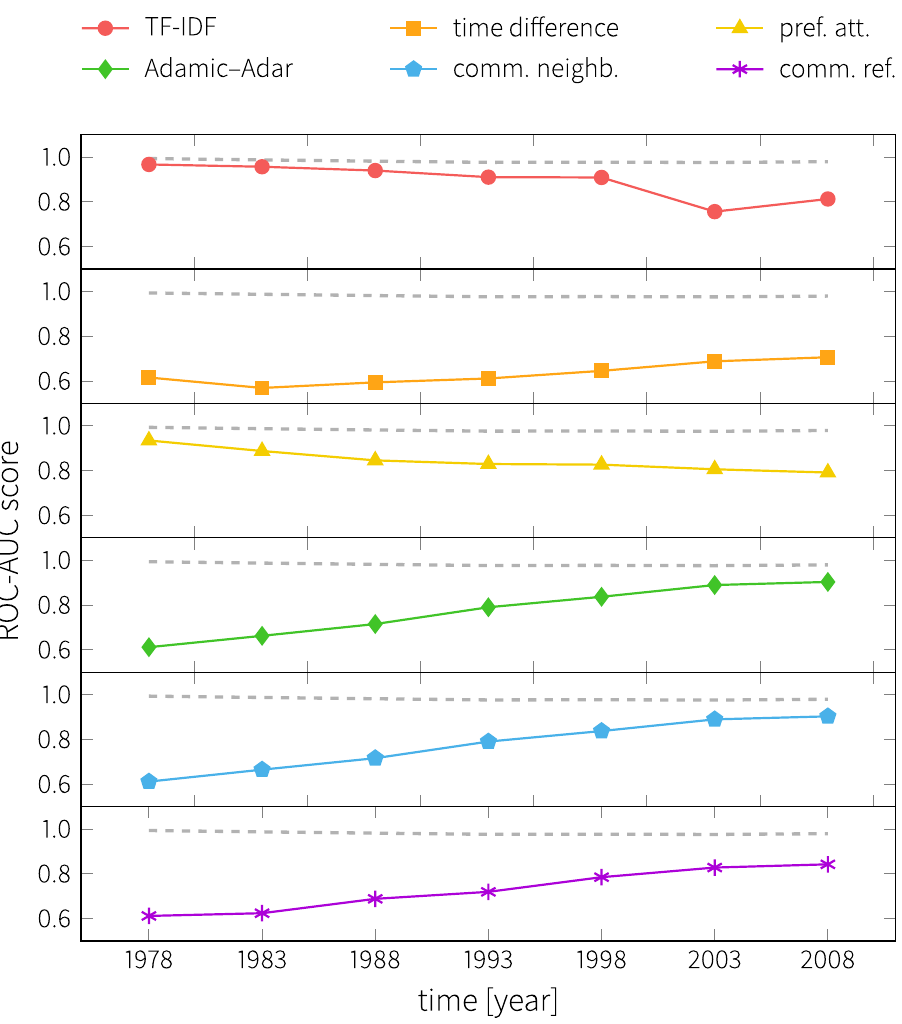
Figure 3. Details of feature usage inside the decision trees. The curves show the fraction of decision nodes in the decision trees that use a specific feature in different levels of the trees (they add up to one). For each feature, we calculate the number of (internal) decision nodes that make the split based on the value of that feature, normalized by the total number of nodes in that level. Results are averaged over all trees in a random forest and over 5 independent forests. Black lines indicate the boundary between nodal (lower) and structural (upper)